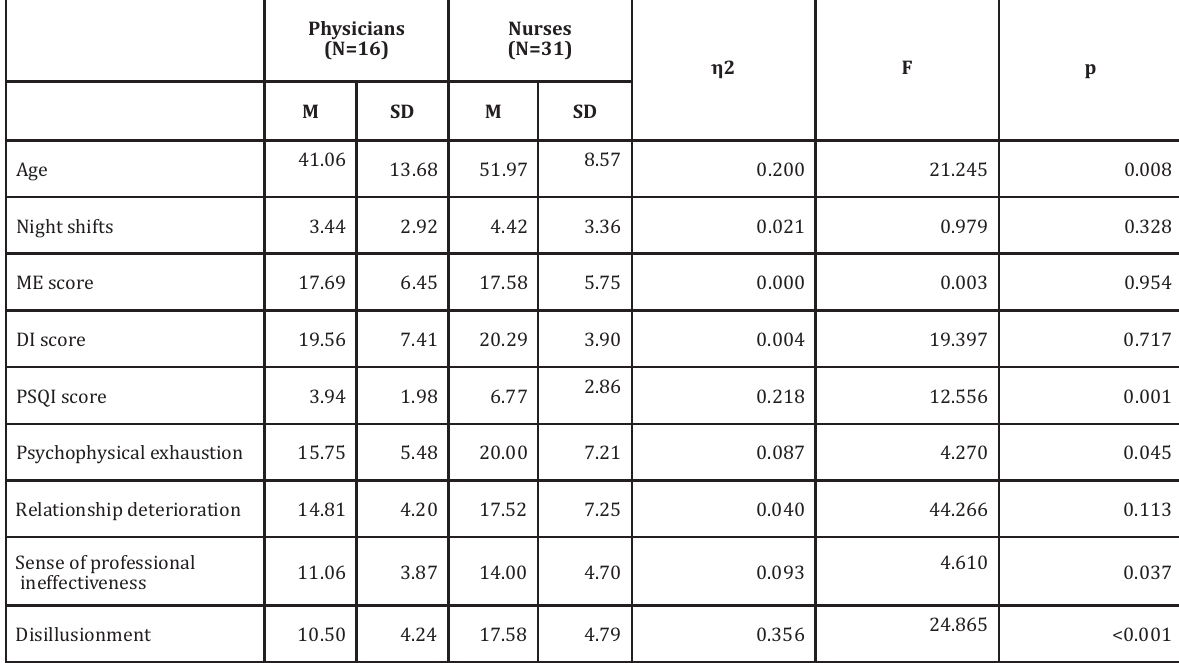
Table 1. Comparison of the mean values (M) with the standard deviations (SD) of the variables of interest between the studied groups of physicians and nurses. Physicians